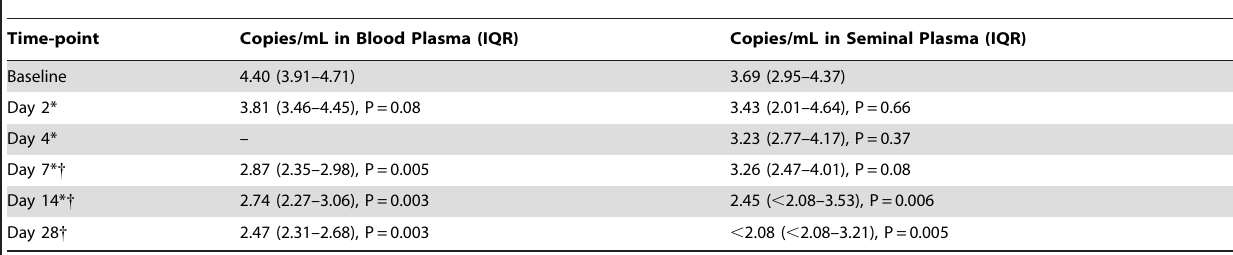
Table 1. Median Log 10 HIV-1 RNA Level During the First Month of Antiretroviral Therapy among 13 Kenyan Men.